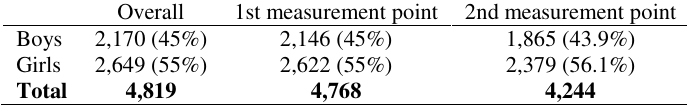
Table 3 Participating students’ gender